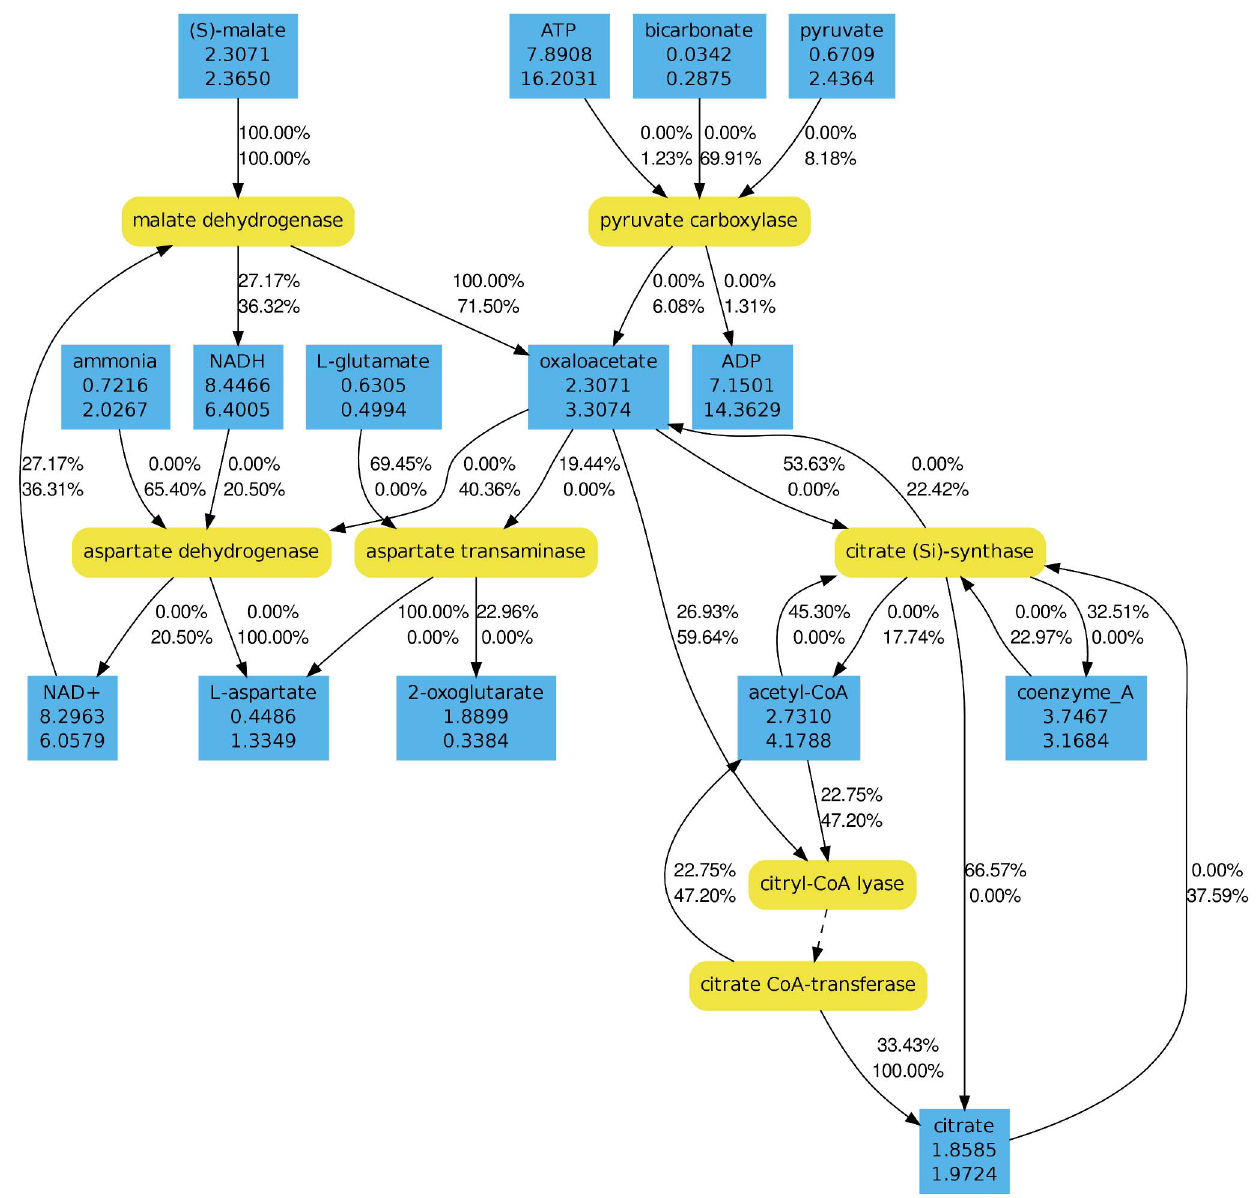
Figure 5. Metabolic context of oxaloacetate during growth on DMSP. Reactions are shown in yellow (round boxes) while metabolites are shown in blue (angular boxes). The total flux through a metabolite is given in mmol/ ( g DW h ). Outgoing and incoming fluxes are given in percentages of the total flux. The upper numbers correspond to a dark states and the lower numbers to light states. In both cases growth on DMSP was simulated under aerobic conditions.